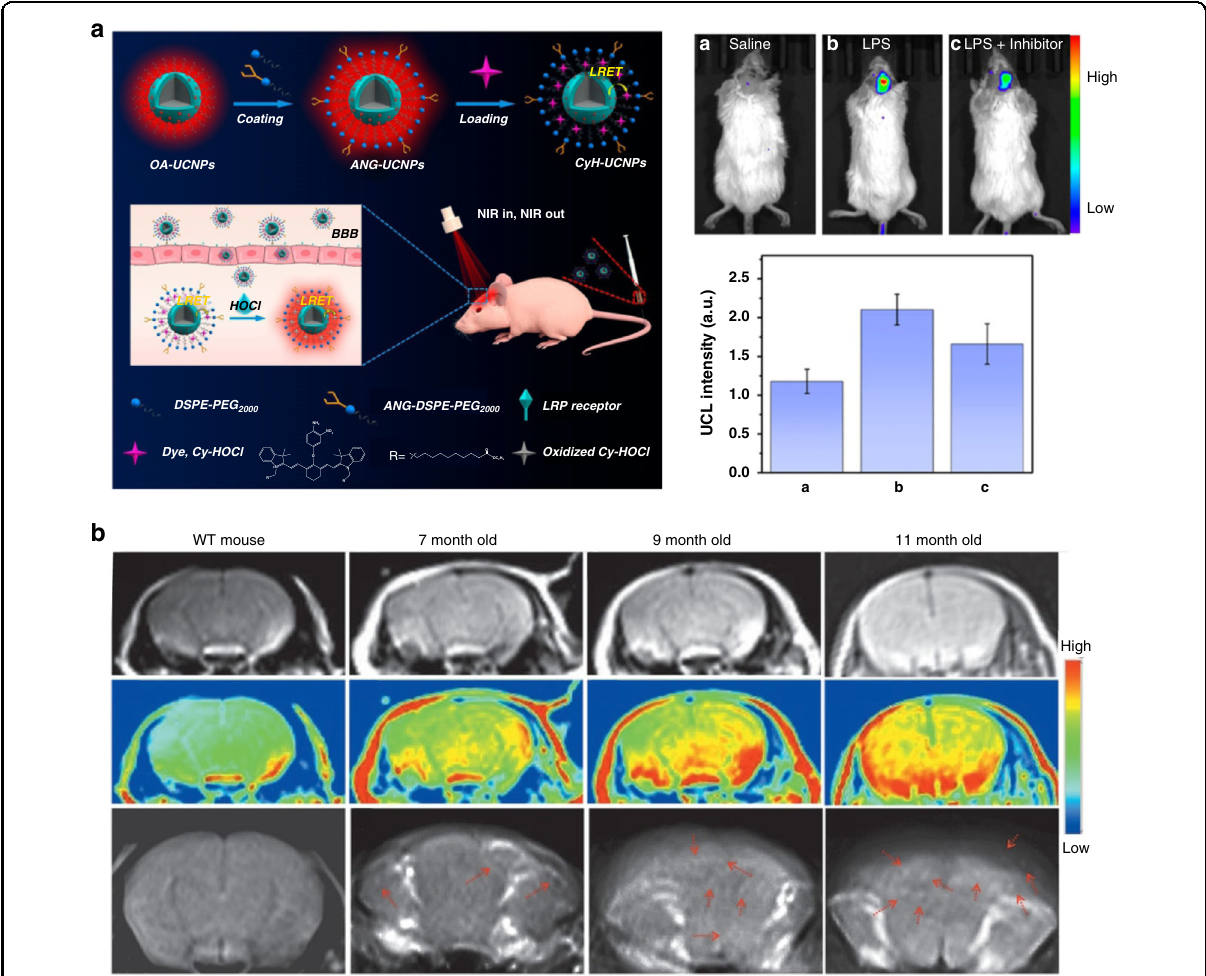
Fig. 8 Rare-earth based materials for detecting the brain diseases. a HOCl-activated upconversion nanoprobes for visualizing lipopolysaccharide (LPS)-induced neuroin fl ammation (left). Intravital fl uorescence imaging of neuroin fl ammation in the LPS-induced neuroin fl ammation model (right). Reprinted with permission from ref. 94 . Copyright 2020 American Chemical Society. b MRI (top), the respective color mapped images (middle) and in vitro images (bottom) of WT and Tg mice brain at different ages after injection of NaGdF 4 :Yb 3 + /Tm 3 + @NaGdF 4 @SiO 2 @F-SLOH. Reprinted